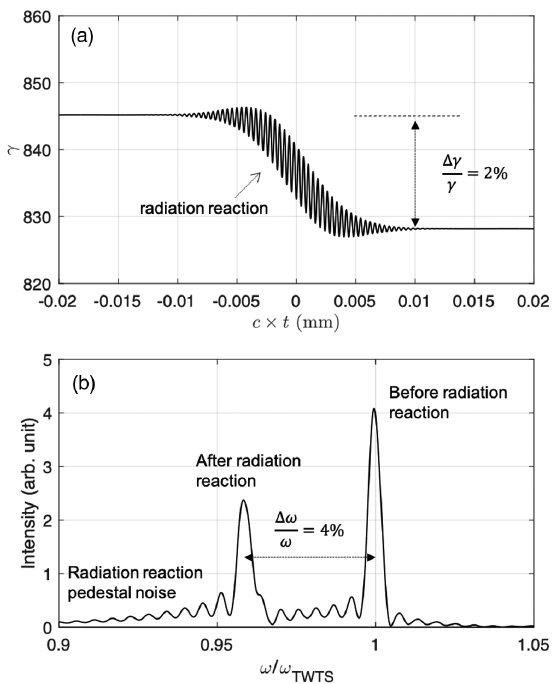
FIG. 2. A relativistic electron is continuously diagnosed with TWTS for its spectrum when it is decelerated by the radiation reactionforce.(a).Electronenergydropsbyacertainamountdueto radiation reaction friction. (b). Electron TWTS spectrum contains two peaks that correspond to energies before and after radiation reaction process. Simulation parameters can be found in Table